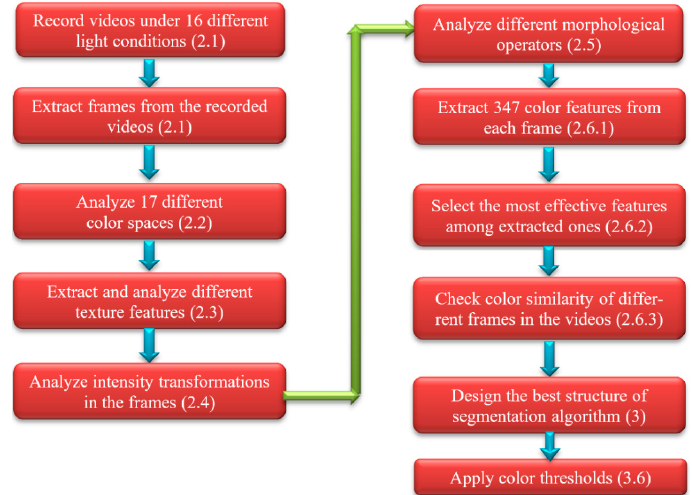
Figure 1. Steps in the development of a complete algorithm for color segmentation of apples. In parentheses, a reference to the section/subsection where each step is described.